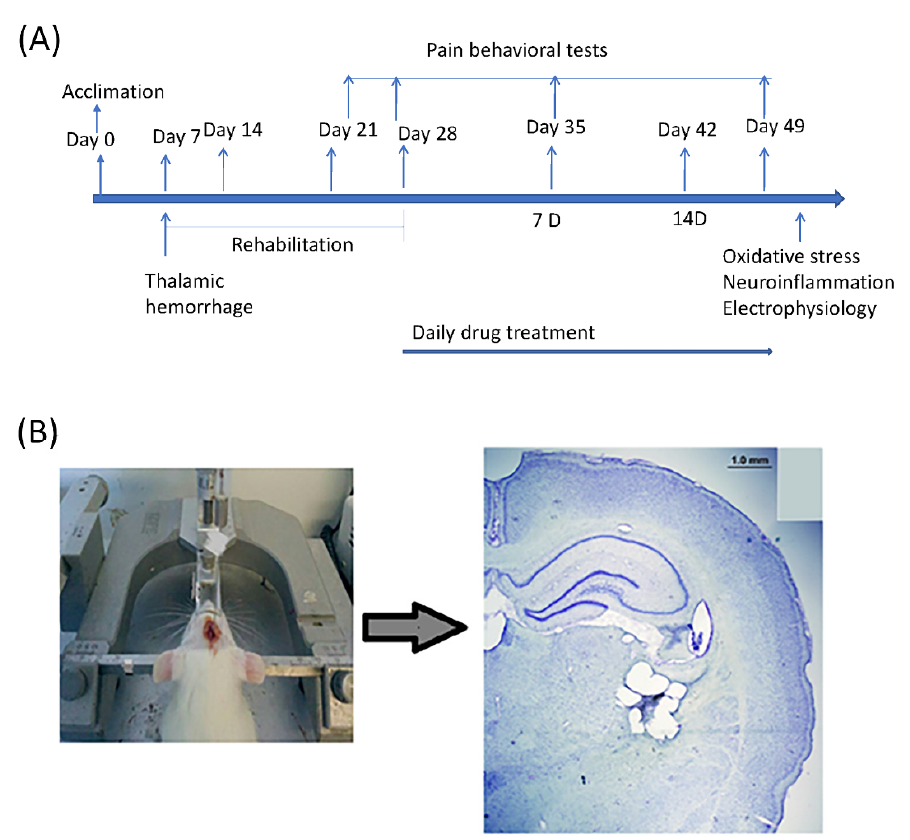
Figure 8. ( A ) Flowchart for experimental design. ( B ) Microinjection of collagenases to induce lesions of the VPL/VPM in the animal model of central post-stroke pain.